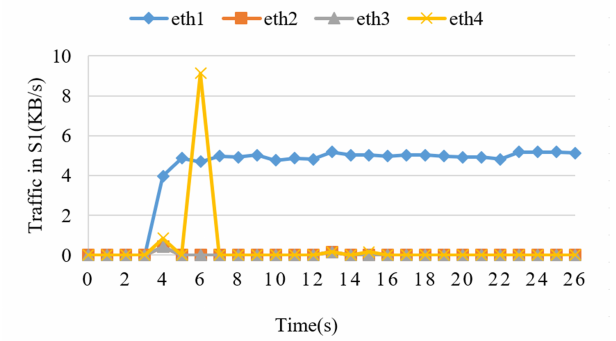
Fig. 7 Real-time traffic of S1 under low-rate attacks. The attack density is 100 packets per second.